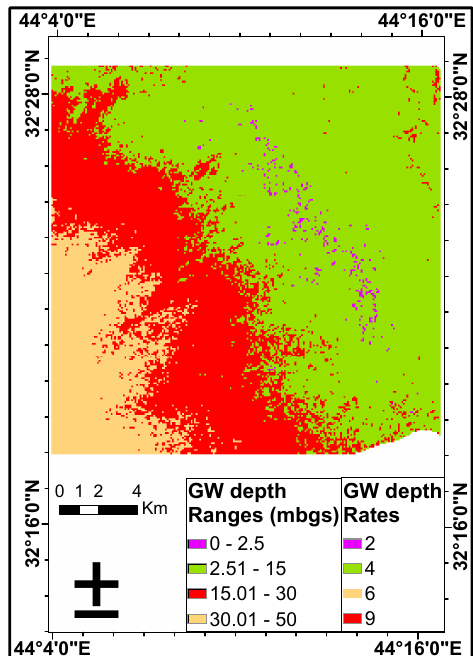
Figure 13. Depth to groundwater in Karbala province—study area (ranges and rates) [11].